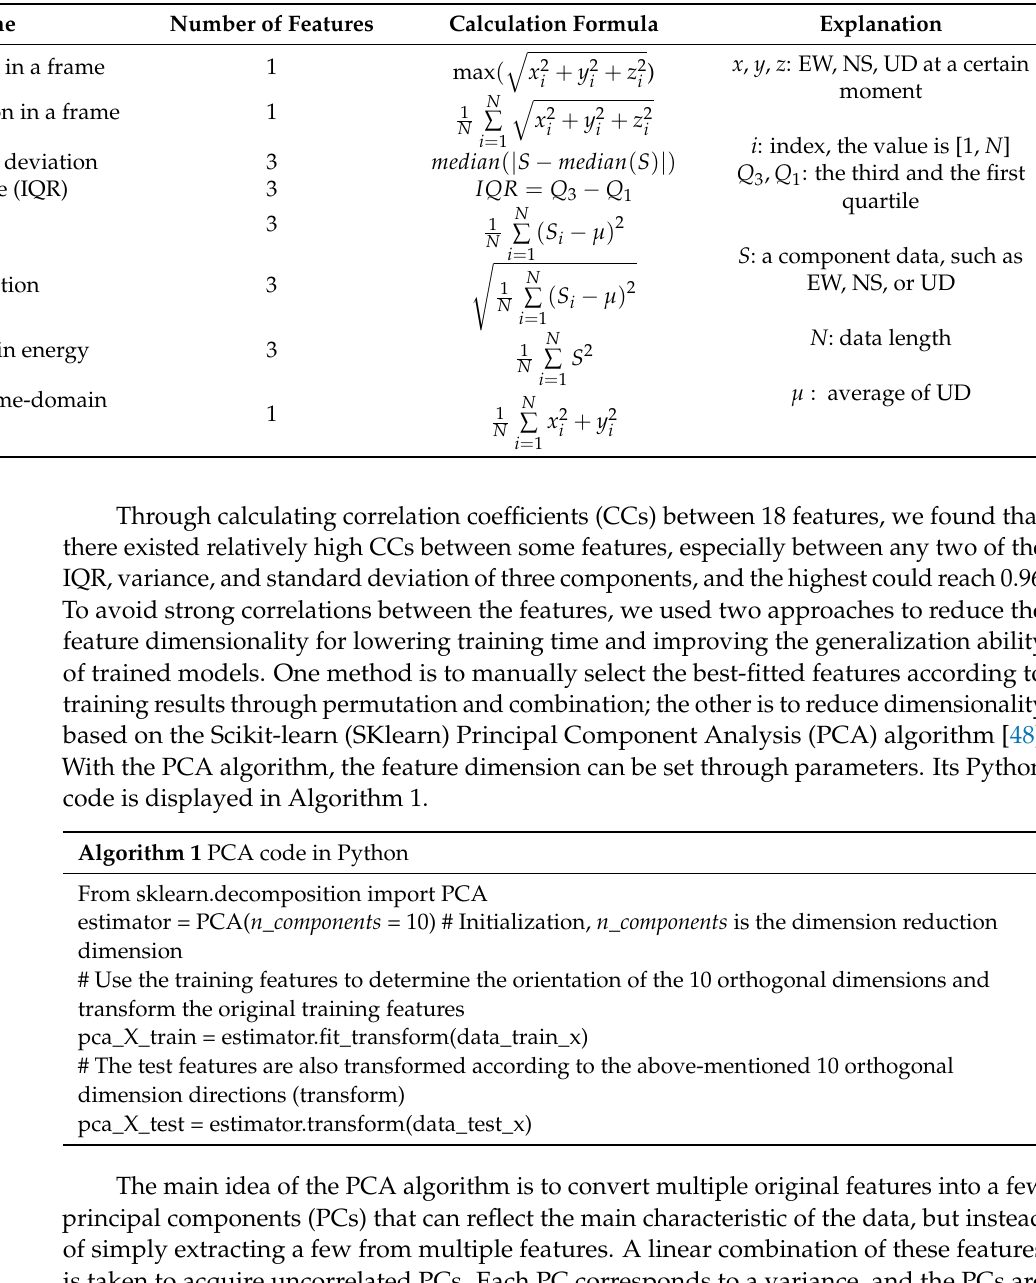
Table 2. Calculation formulas of the selected features in this study. If the number of features is three, it means that this feature will be calculated separately for three components of acceleration data.